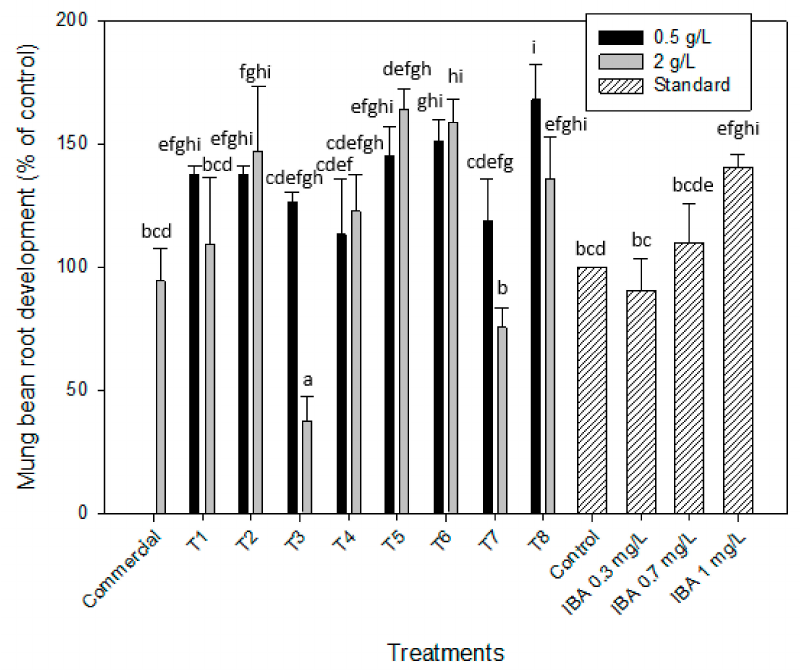
Figure 2. Auxin-like activity of Scenedesmus obliquus biomass when applied in the mung bean root development bioassay for the eight microalgal treatments (T1–T8) at the two concentration tested (0.5 and 2 g / L) using indole-3-acetic acid (IBA) at 0.3, 0.7 and 1 mg / L as the auxin standard. Results are shown as mean ± SE ( n = 3). Different letters indicate significant differences ( p < 0.05) within each